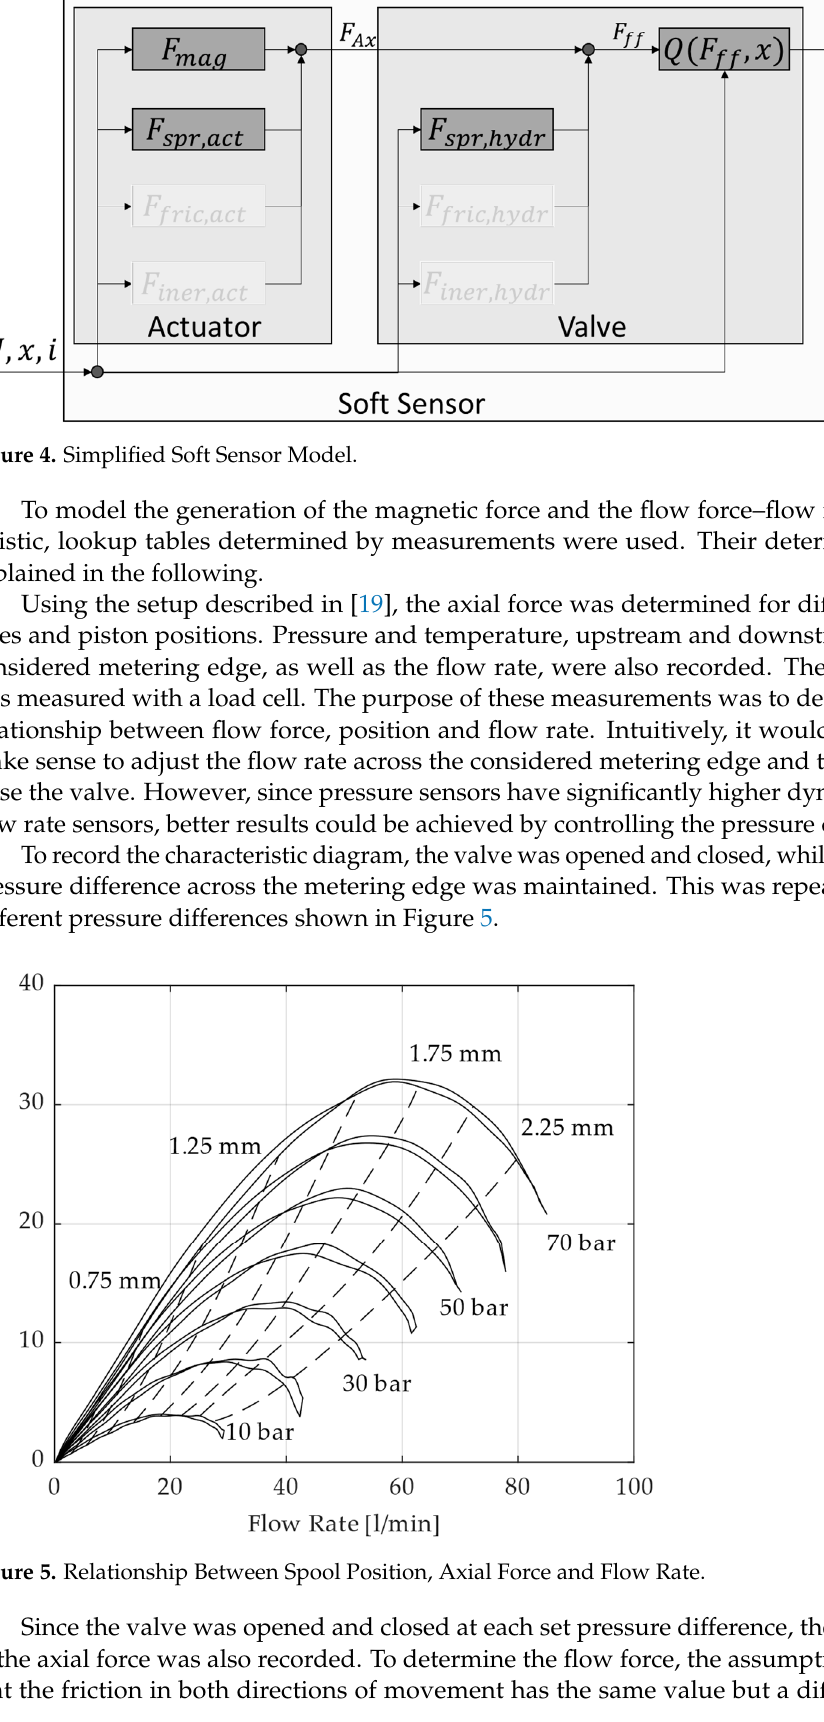
Figure 6. Schematic Depiction of the Mechanical Setup for Measuring Solenoids. On the left, the Solenoid to be Measured. On the left side, the solenoid to be measured is mounted in a rigid frame. A movable carriage driven by a servo motor allows for precise, dynamic positioning of a mechanical stop against which the armature presses. The force generated by the armature is recorded by a force sensor (MES KM40). Both the position of the armature and the position of the carriage are measured to precisely control the armature position and eliminate possible position deviations, e.g., due to backlash or the limited stiffness of the force sensor. Figure 7 schematically shows the electrical part of the experimental setup. The circuit consists of the solenoid itself, an amplifier and a low-side measurement shunt (3 Ω (cid:3399) 0.02%) for current measurement. The amplifier (Kikusuiu PBZ80-5) allows for, in push/pull configuration, the application of arbitrary currents and voltages. The solenoid is highlighted by a gray rectangle and is represented by an inductor and an ohmic resistor.